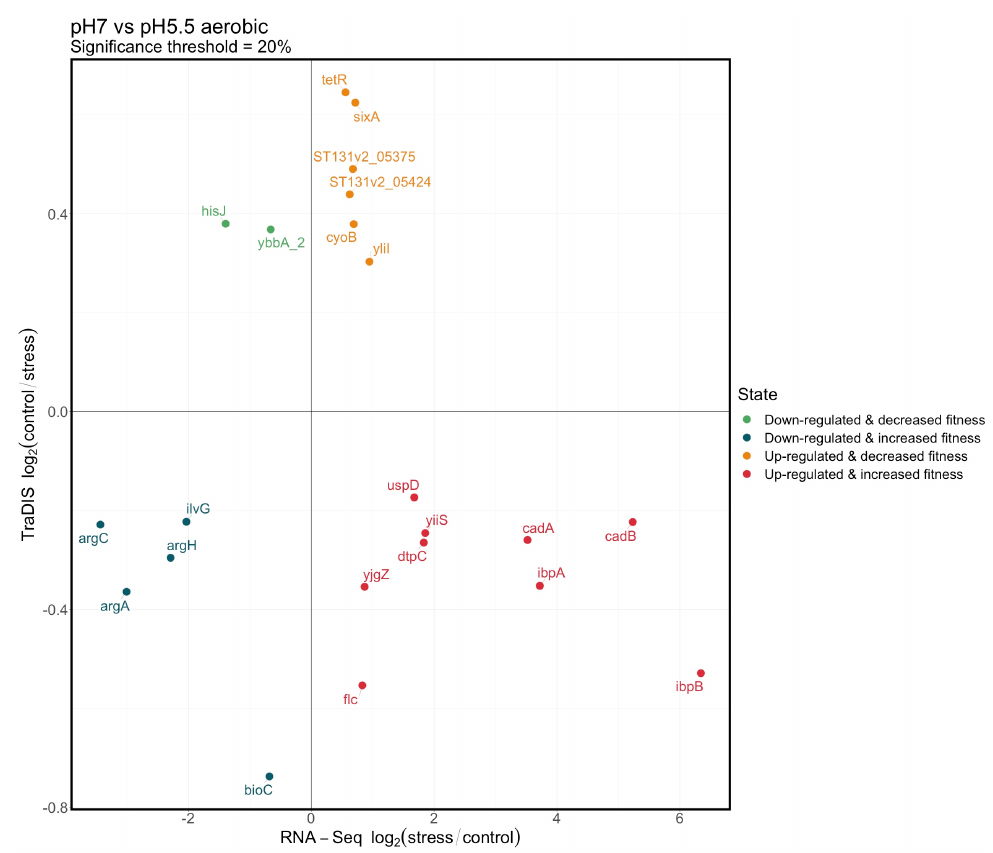
Figure 7. RNAseq and TraDIS scores plotted against each other for two selected conditions. All values are log 2 fold change: stress/control for RNAseq and control/stress for TraDIS. ( A ) Relative scores in cultures grown aerobically at pH 5.5 with and without acetic acid (significance cut off 1%). ( B ) Relative scores for cultures grown aerobically at pH 5.5 vs. pH 7 (significance cut off